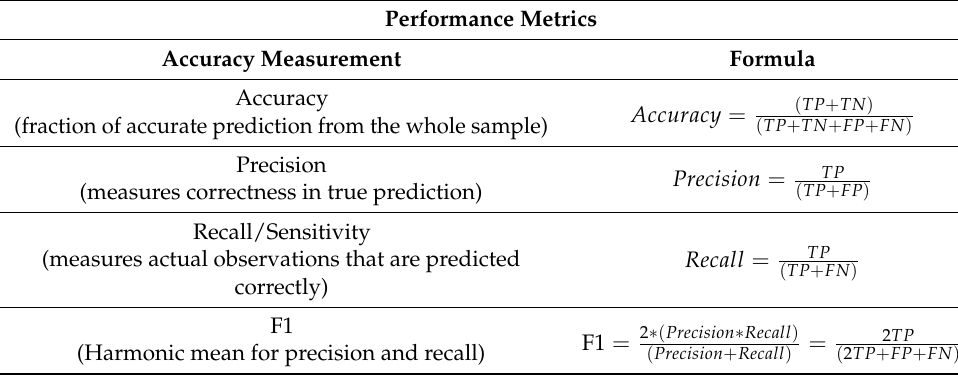
Table 3. Formulas for feature